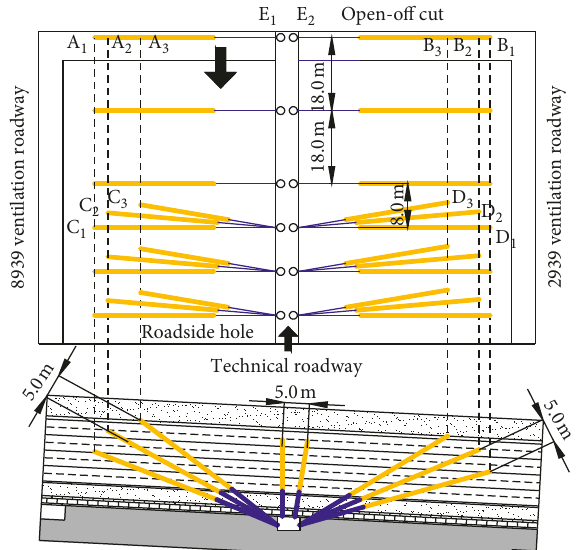
Figure 14: Plane and section view drawings of blasting presplitting